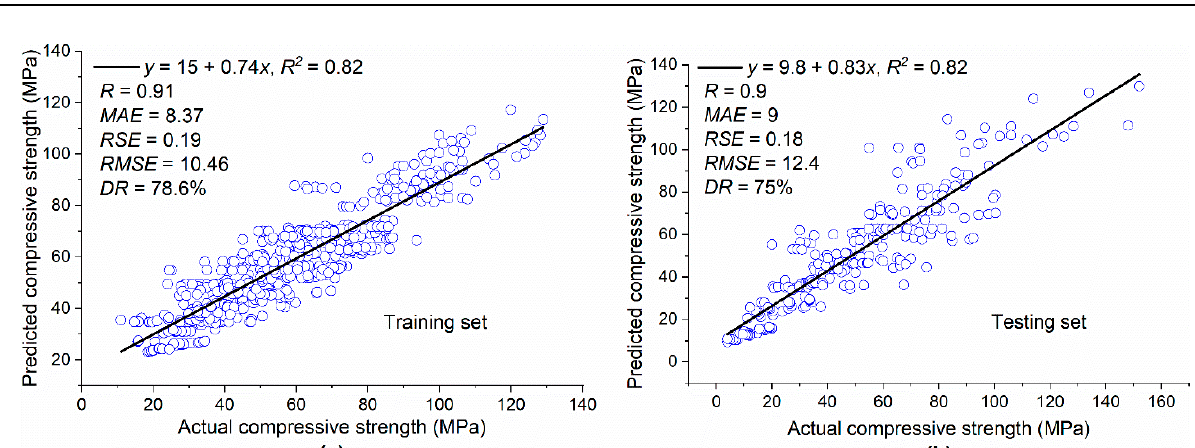
Figure 5. Actual and predicted values of CS: ( a ) training set; ( b ) testing set.